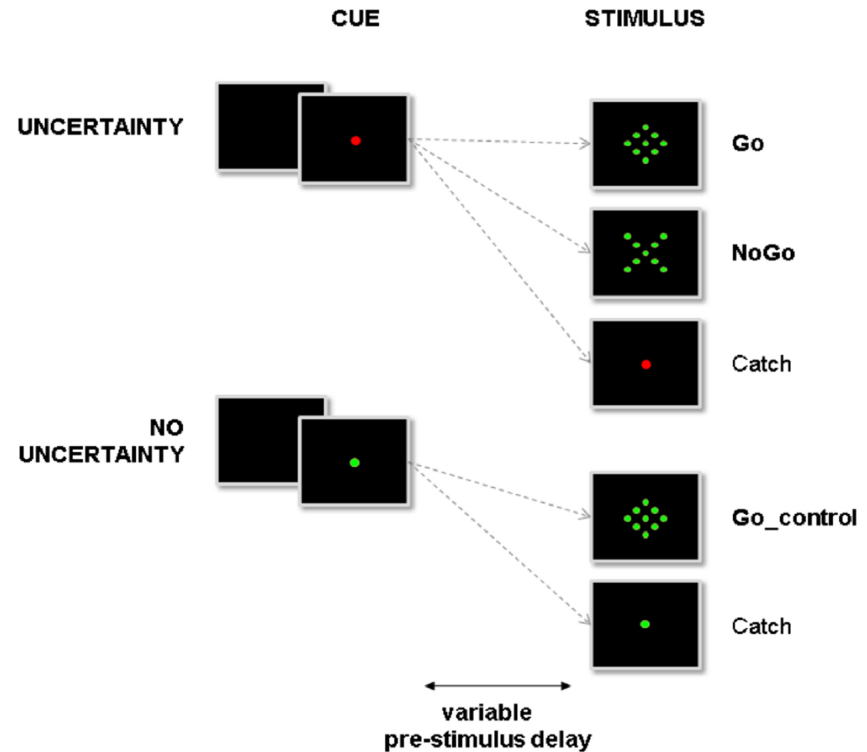
Figure 2. Overview of the experimental setup. Subjects were instructed to react to the presentation of a go signal (diamond) by pressing a button. At the beginning of a trial, the central fixation point (cue) could turn either red or green, indicating, respectively, that NoGo stimuli (X) could or could not be presented. In the former condition (uncertainty condition), proactive inhibition was required during the pre-stimulus period to avoid erroneous automatic responses to NoGo stimuli. In the latter condition, proactive inhibition was not required during the pre-stimulus period. Subjects could react automatically to any upcoming target (no uncertainty condition).